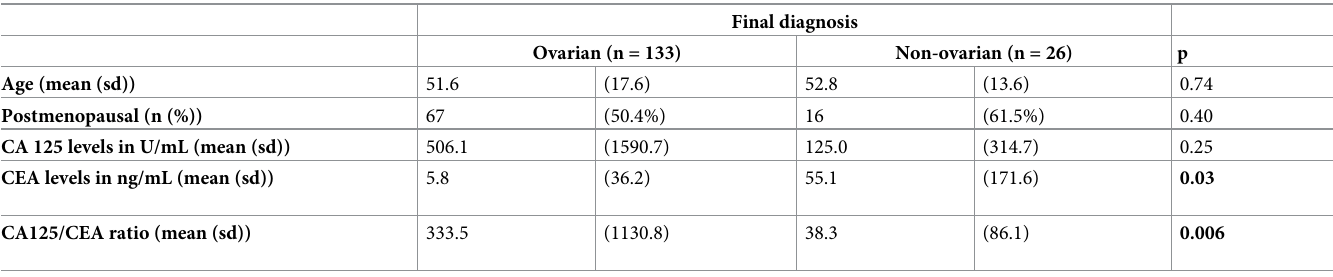
Fig 2. Conditional Inference Tree (CIT) for non-adnexal origin of the tumor in the adnexa. Each group denotes a subset of women with the characteristics indicated in the CIT. Significance level set to alpha = 95% (tree will branch only where p < 0.05). Variables included in CIT modeling: Upfront ultrasound classification of tumors into ovarian/ non-ovarian, CA125/CEA ratio, MRI signal in diffusion-weighted. https://doi.org/10.1371/journal.pone.0283212.g002 Table 1. Key features of women with adnexal